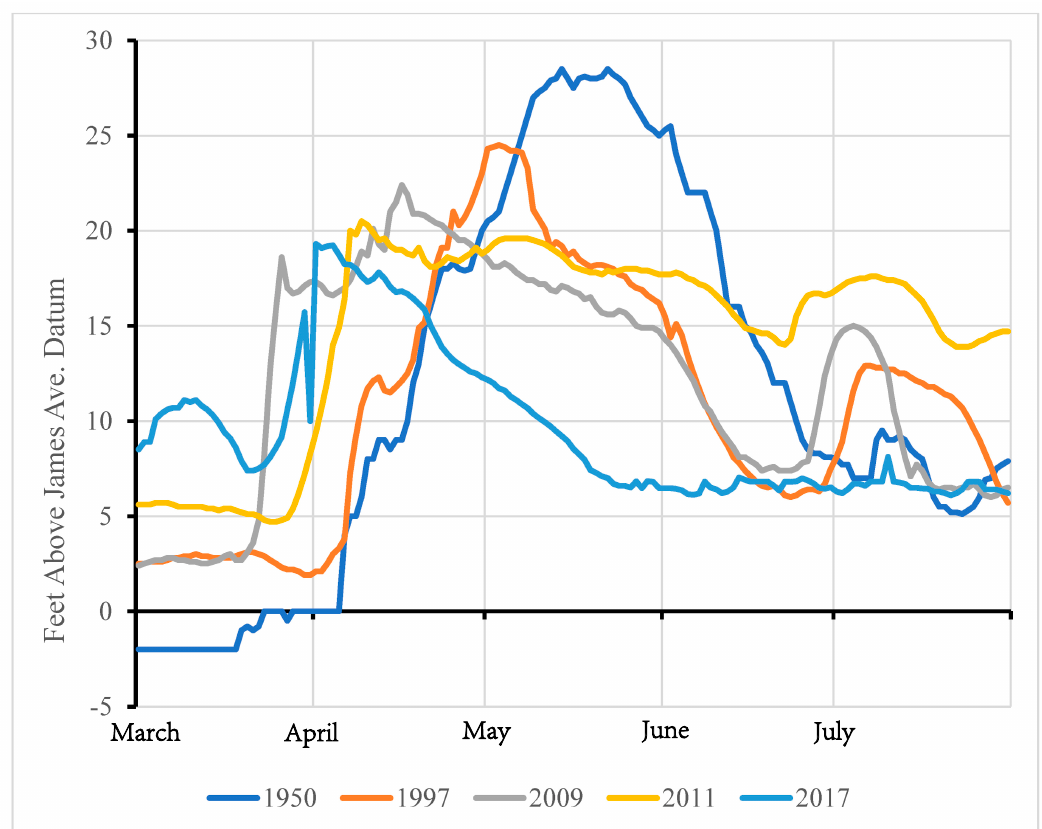
Figure 2. Historic Red River water levels at James Avenue, Winnipeg, 1950–2017. The zero point of the gauge at James Avenue is 727.57 ft. above mean sea level. (Sources of data: City of Winnipeg, and Water Survey of Canada,